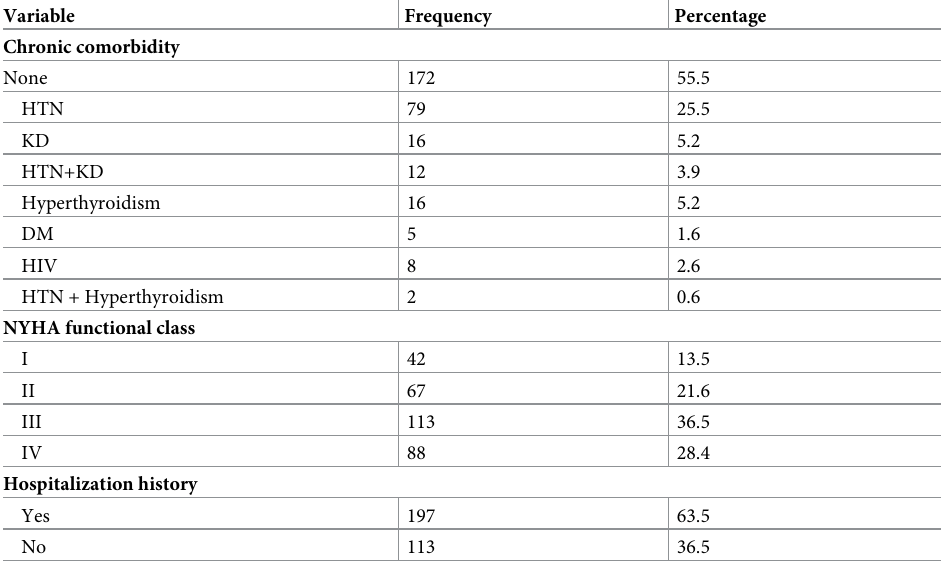
Table 2. Clinical profiles of heart failure patients, Gondar University referral hospital, Northwest Ethiopia, May 2017 (n =